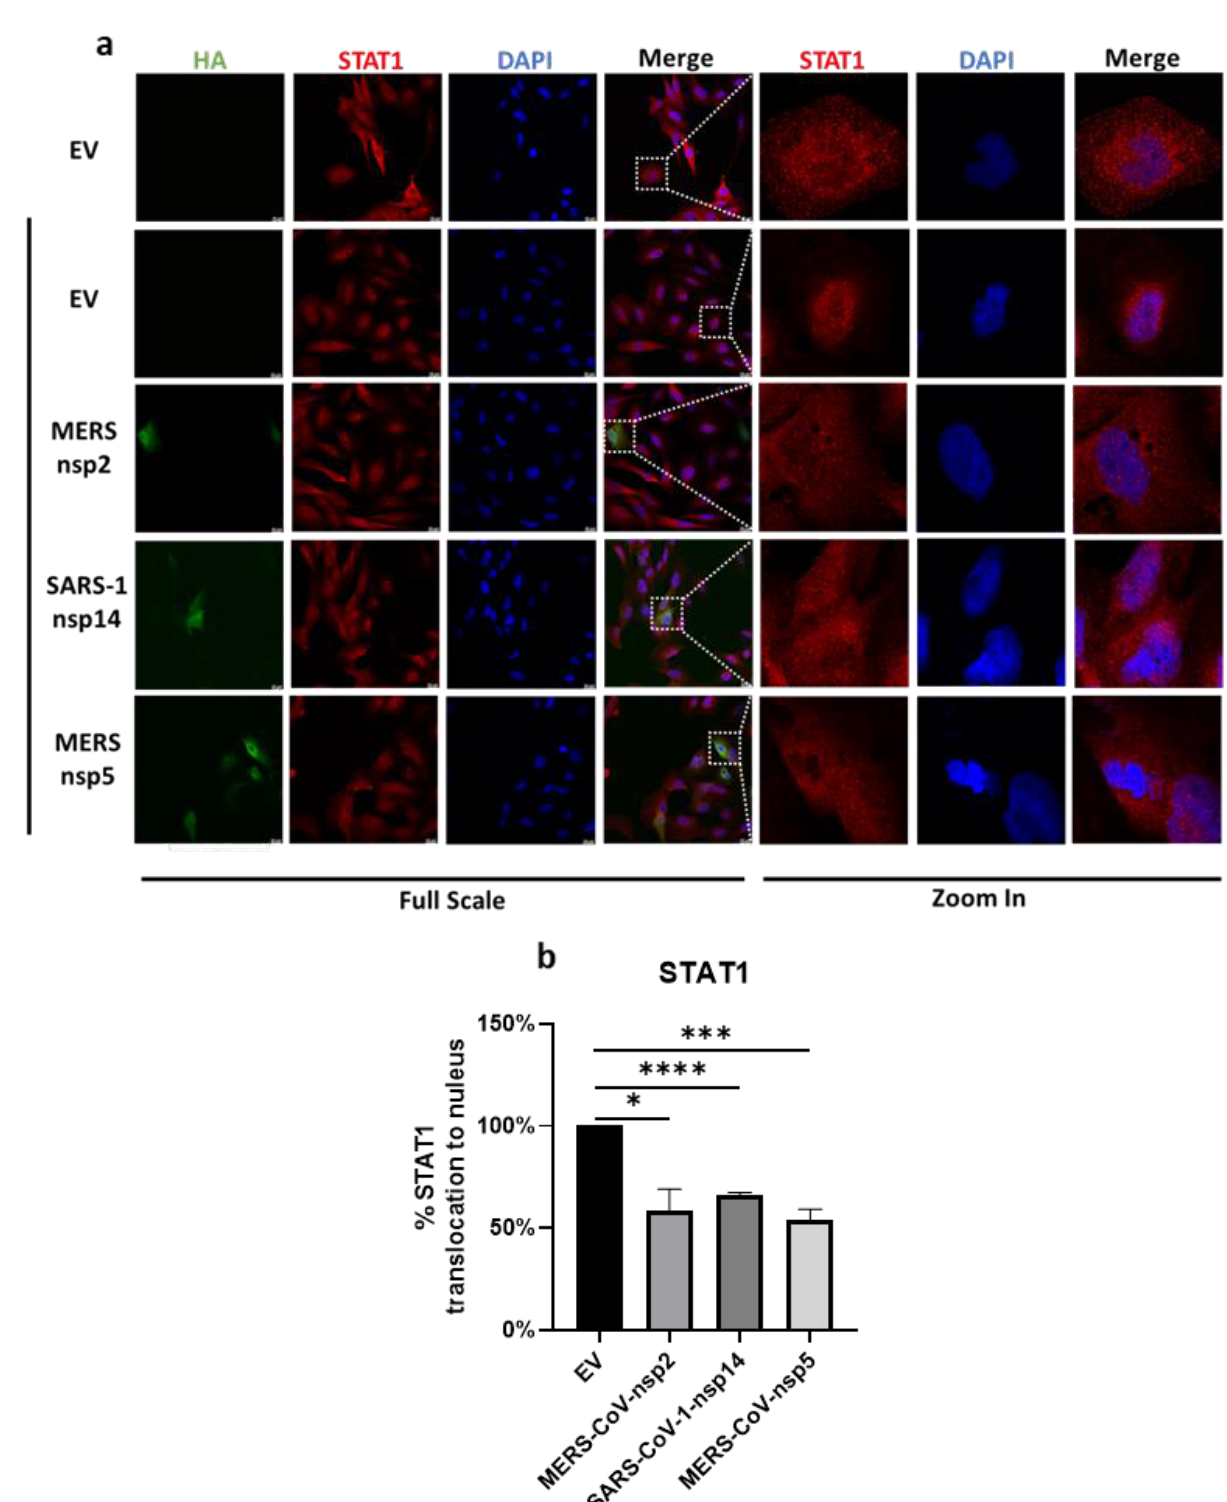
Figure 6. MERS-CoV-nsp2, SARS-CoV-1-nsp14, and MERS-CoV-nsp5 expression block IFN-α-mediated STAT1 nuclear translocation of BEAS-2B cells. ( a ) Confocal microscopy images of BEAS-2B cells transfected with Empty Vector (EV) or HA-tagged MERS-CoV-nsp2, SARS-CoV-1-nsp14, or MERS-CoV-nsp5. After 24 h, cells were stimulated for 30 min with IFN-α (1000 U/mL) then fixed and permeabilised. Anti-HA and anti-STAT1 were probed as primary antibodies, and anti-CF™ 568 and anti-Alexa Fluor 647 were probed as secondary antibodies to monitor HA expression and STAT1 subcellular localisation. Nuclei were stained by DAPI. Each full scaled image was then zoomed in for presenting single transfected cells. ( b ) Quantification of nuclear translocation of STAT1 in control, MERS-CoV-nsp2, SARS-CoV-1-nsp14, and MERS-CoV-nsp5-positive cells from